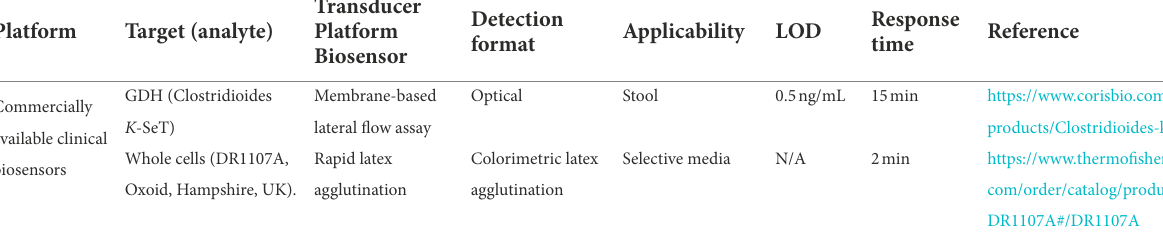
TABLE 2 Examples of commercially available clinical biosensors kits for Clostridioides difficile infection.